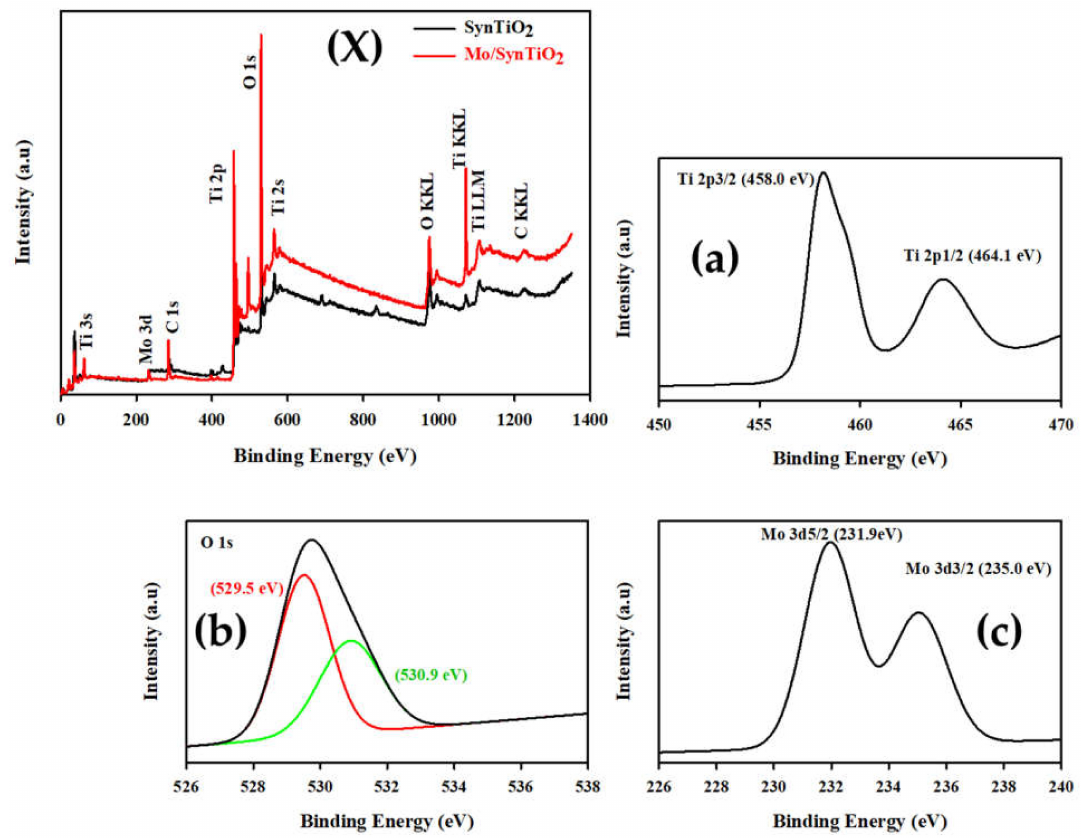
Figure 3. XPS measurement: ( X ) survey spectrum of unmodified SynTiO 2 (black line), and modified Mo/SynTiO 2 (red line) and deconvoluted elemental spectra of ( a ) Ti 2p; ( b ) O 1s; and ( c ) Mo 3d for modified Mo/SynTiO 2 material